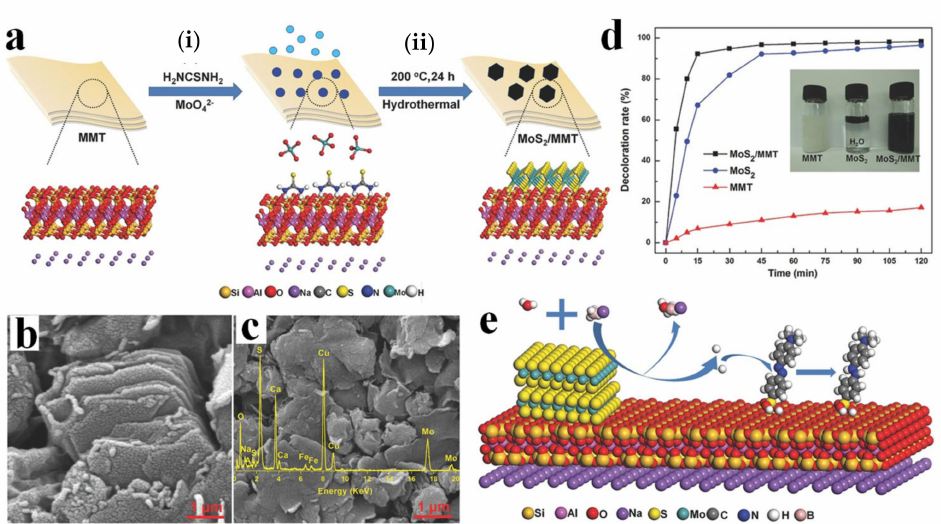
Figure 7. ( a ) Illustration of synthesis strategy for molybdenum disulfide/montmorillonite (MoS 2 /MMT) composite: ( i ) adsorption of thiourea on the surface of MMT; ( ii ) hydrothermal synthe- sis of MoS 2 /MMT at 200 ◦ C for 24 h; SEM images of ( b ) MMT and ( c ) MoS 2 /MMT, the inset shows the EDS spectrum of MoS 2 /MMT; ( d ) decoloration of methyl orange (MO) with MMT, MoS 2 and MoS 2 /MMT, and the inset shows digital photograph of the samples dispersed in water; ( e ) schematic illustration for the catalytic reaction mechanism. Adapted with permission from Ref. [163].